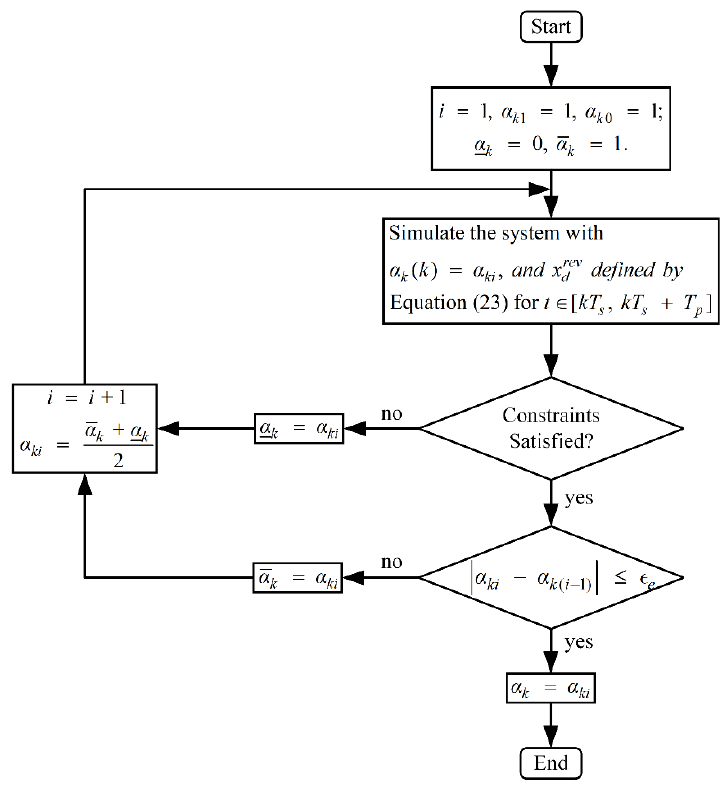
Figure 2. Bisectional search algorithm to optimize α k